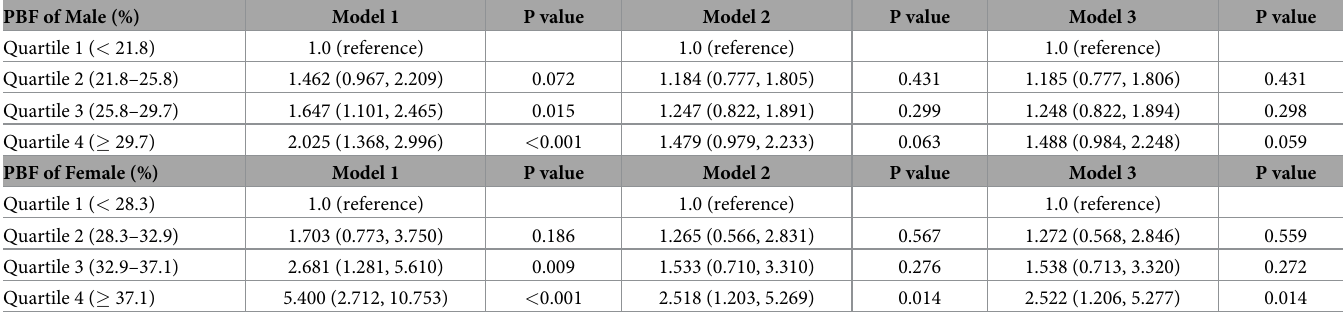
Table 6. Risks of diverticulosis between percentage of body fat and genders (by quartile of percentage of body fat). PBF of Male